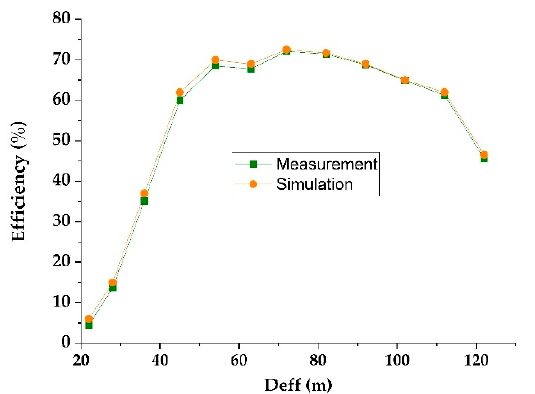
Figure 16. Simulated and measured RF ‐ to ‐ DC conversion efficiency for 2 k Ω resistance load.